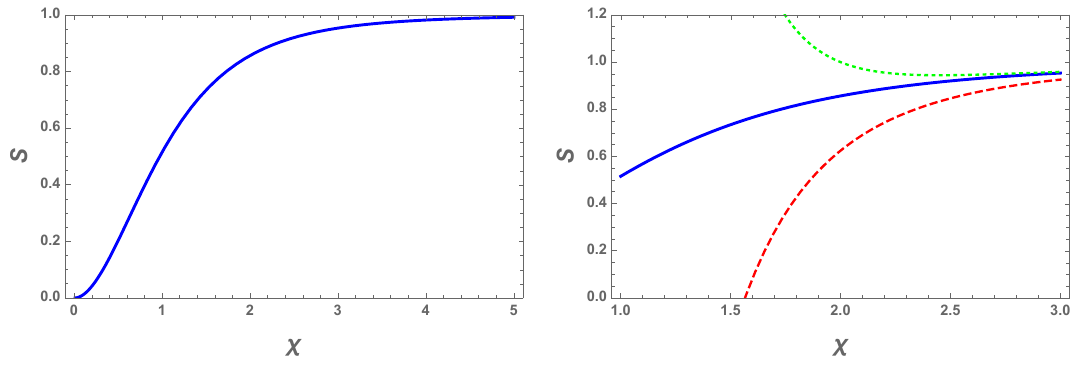
Figure 1 . The action (2.12) of the instanton-anti-instanton con(cid:12)guration as the function of (cid:31) = R=(cid:26) (solid line). S ( (cid:31) ) approaches one at (cid:31) ! 1 where the interaction potential vanishes, and S ! 0 at (cid:31) ! 0 where the instanton and the anti-instanton mutually annihilate. The plot on the right also shows the leading-order (dashed line) and the next-to-leading-order (dotted line) approximations in (2.17). The regime of interest to us is 1 : 5 < (cid:31) < 1 : 7, where we have to use the complete action (solid line).